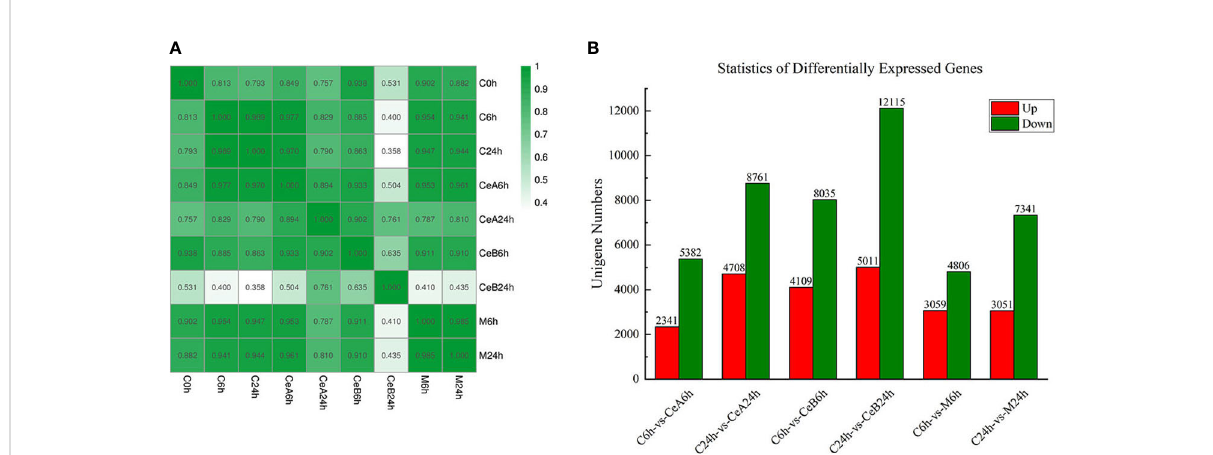
FIGURE 2 (A) Pearson correlation coef fi cients of all 9 samples. The expression level of each gene (the entire gene set) for each pair of samples was used to calculate the Pearson correlation coef fi cients, and the correlation coef fi cients between the two samples were visually displayed as a heat map. (B) The numbers of the up-regulated and down-regulated unigenes in the six